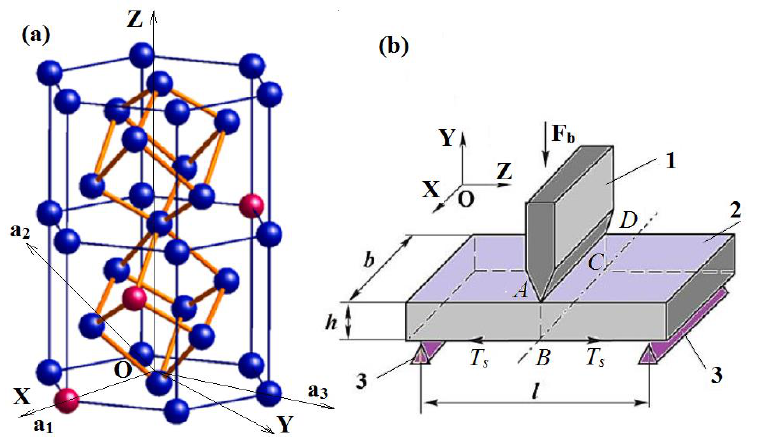
Figure 2. The main axes of the Bi–Sb crystal lattice ( a ) and the bending test scheme ( b ). ( a ) a 1 , a 2 , and a 3 are binary axes in a hexagonal lattice, where a 1 coincides with the OX axis, OY is the bisectrix axis, and OZ coincides with the trigonal and extrusion axes. ( b ) 1—loading prism, 2—sample, 3—supports, B–C—line of maximum tensile forces T s ; h and b are the height and width of the specimen, respectively, l —distance between the supports. Bending force F b is parallel to the extrusion axis ( F b || OZ || <10 1̅ > or <1 2̅ 1>).